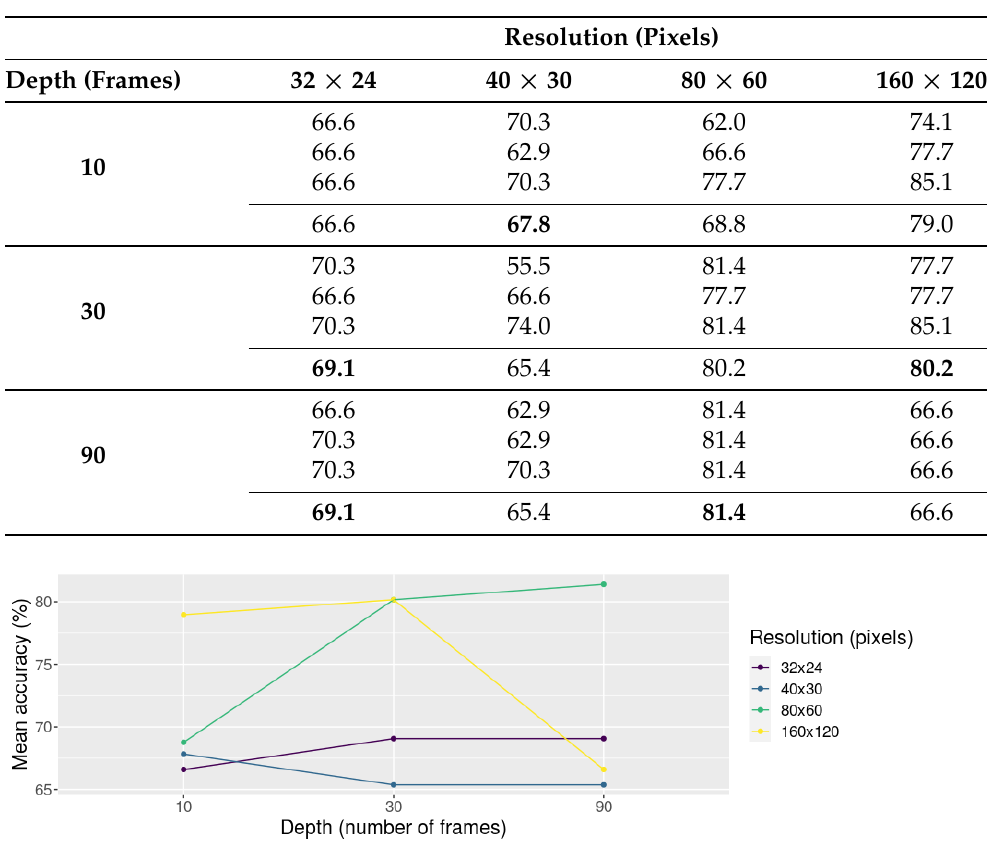
Table 4. Accuracy (%) of the models trained with the 12 different configurations from experiment P03. Each cell presents the accuracy of three independent models per configuration and its average. The best results per resolution are highlighted in bold.